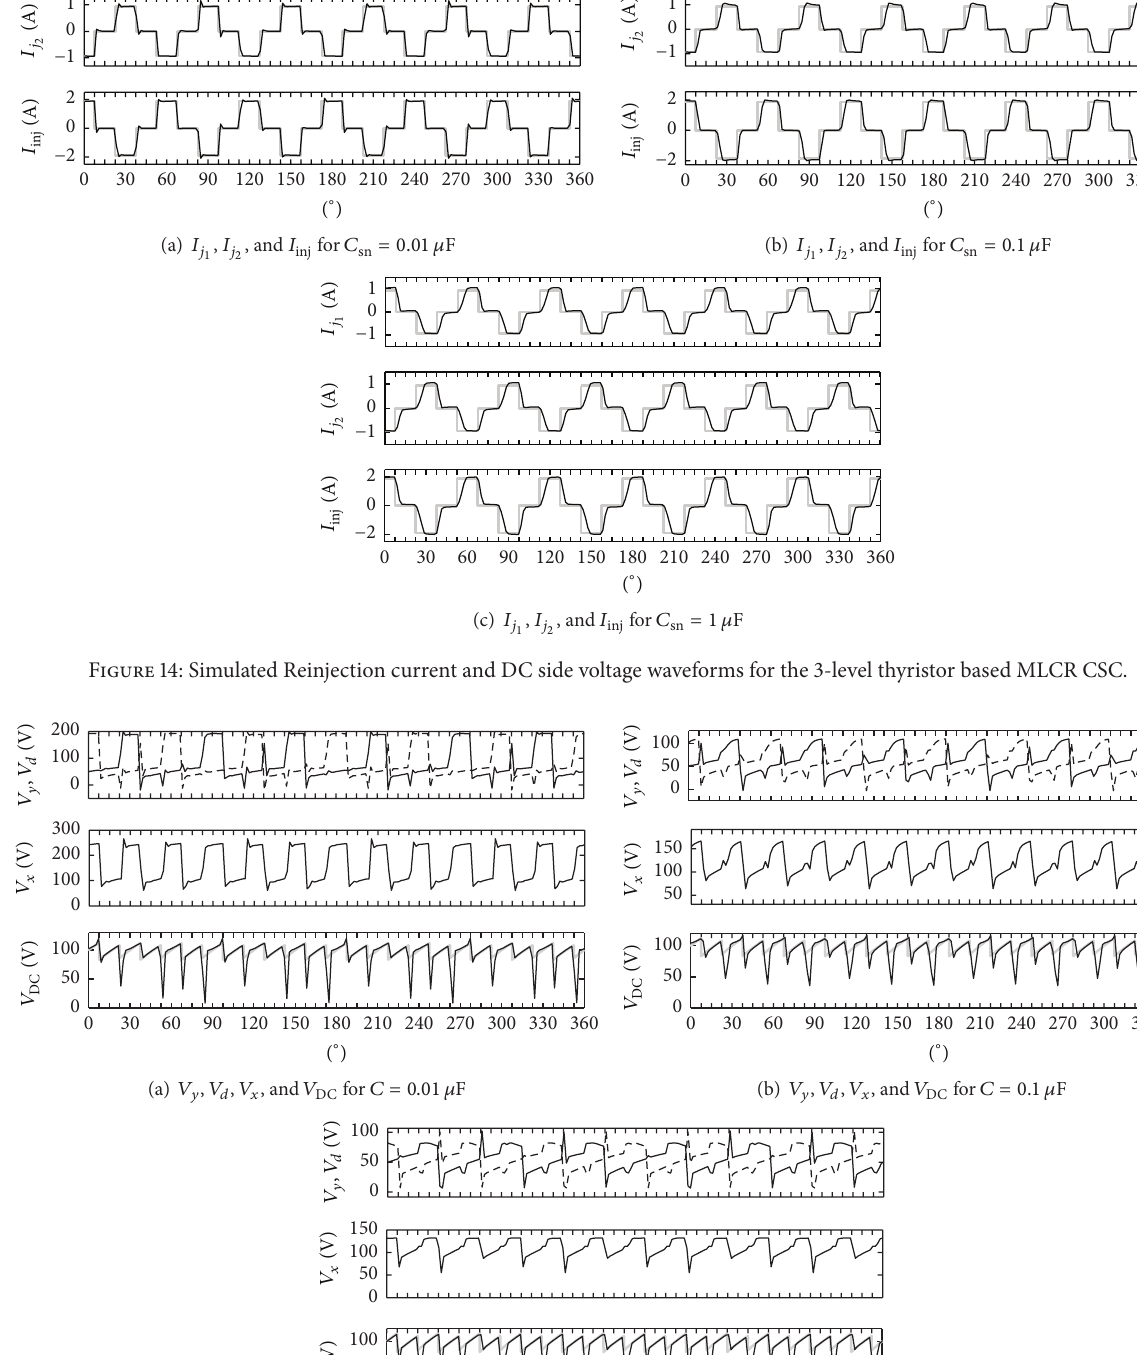
Figure 15: Simulated Reinjection current and DC side voltage waveforms for the 3-level thyristor based MLCR